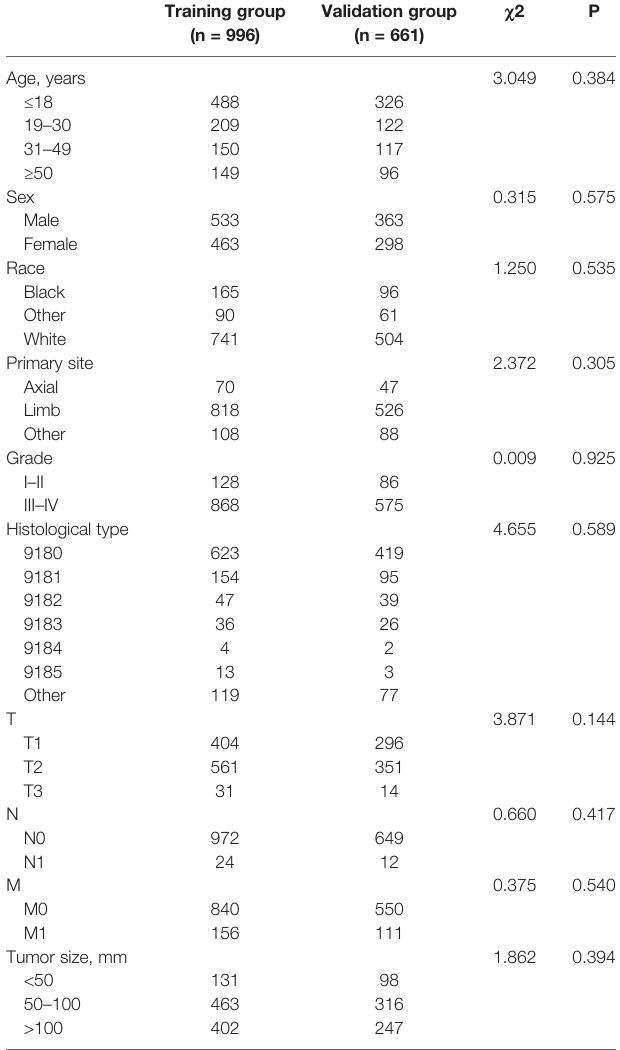
TABLE 1 | Baseline clinical characteristics of osteosarcoma